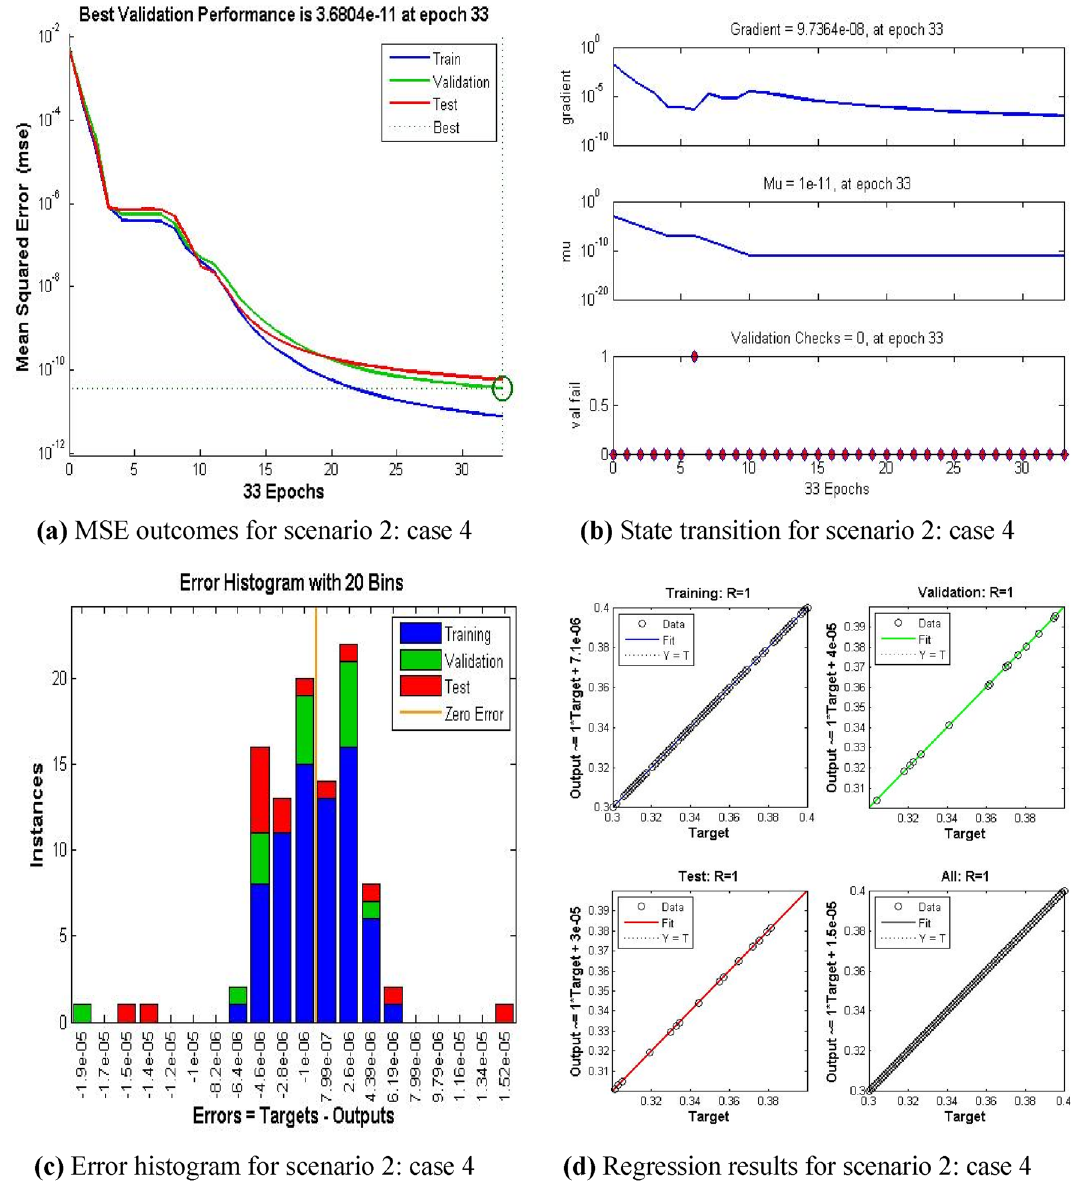
Figure 4. ANNs-BRS outcomes for solving the hybrid nanofluid flow model in scenario 2 case